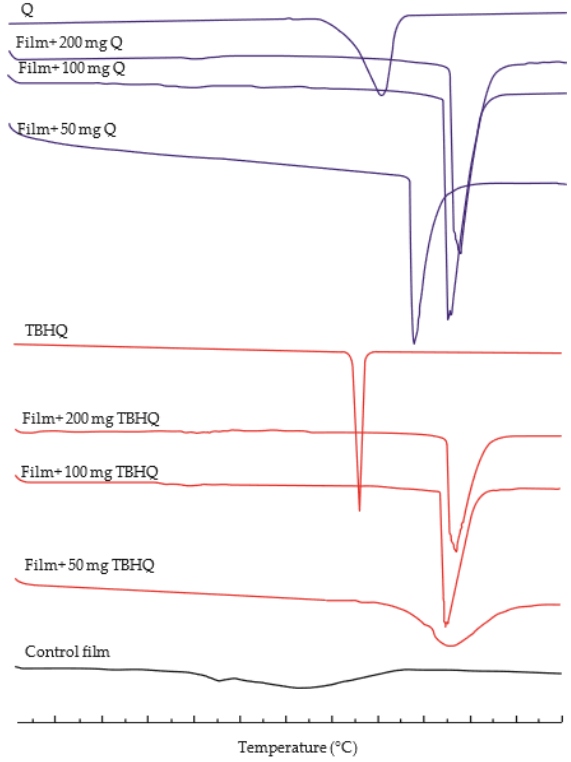
Figure 3. The Differential Scanning Calorimetry (DSC) thermograms of cassava starch/gelatin composite films without antioxidant, with quercetin (Q), and with TBHQ (T).